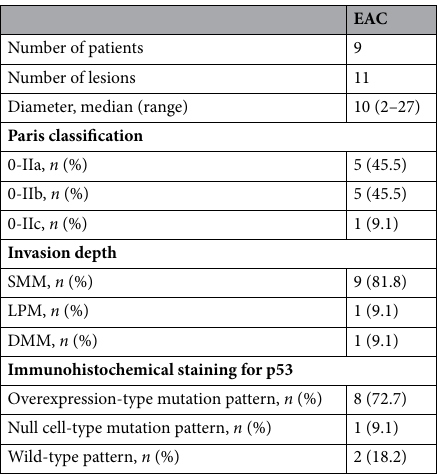
Table 2. Endoscopic and pathological findings in esophageal adenocarcinoma. EAC esophageal adenocarcinoma, DMM deep muscularis mucosae, LPM lamina propria mucosae, SMM superficial muscularis